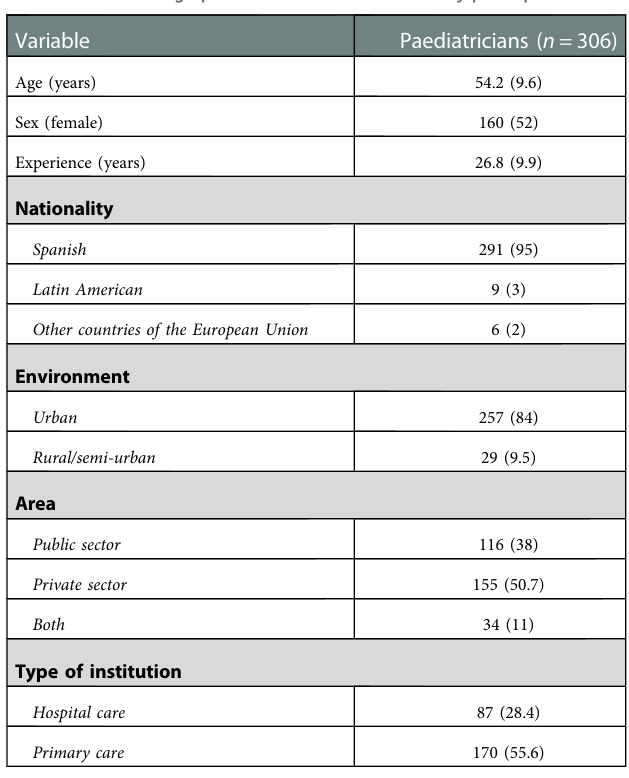
TABLE 1 Sociodemographic characteristics of the study participants.